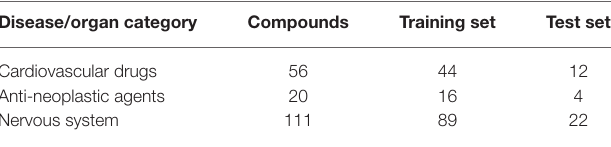
TABLE 1 | The number of compounds, training, and test sets for the three different disease/organ category. Disease/organ